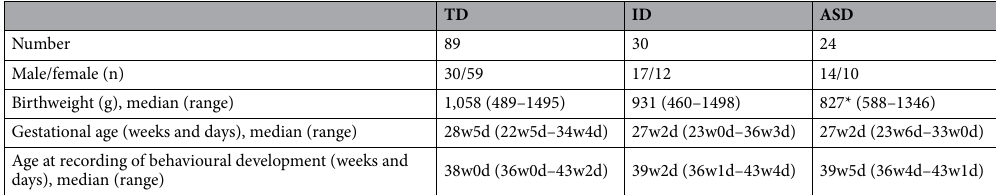
Table 1. Characteristics and developmental outcome of the neonatal assessment group. TD typical development, ID intellectual disability, ASD autism spectrum disorder. * p < 0.05 in comparison with TD group using the Mann–Whitney U test.